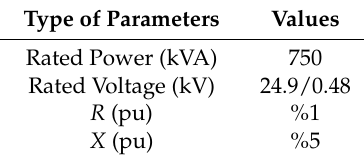
Table A2. Service transformer parameters used in the 34 bus test system.